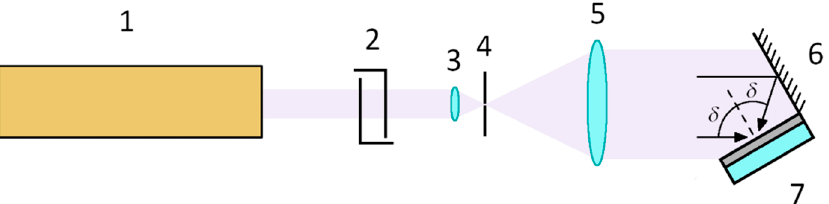
Figure 2. Setup for holographic recording of HL gratings in DCG: 1, argon-ion laser; 2, shutter; 3, microscope objective (40 × ); 4, pinhole (10 µ m); 5, collimator (20 cm focal length); 6, mirror; 7, DCG film coated on a fused silica substrate (2.5 × 2.5 cm 2 ). The angle between the mirror and the DCG plate is maintained constant and equal to 90°.